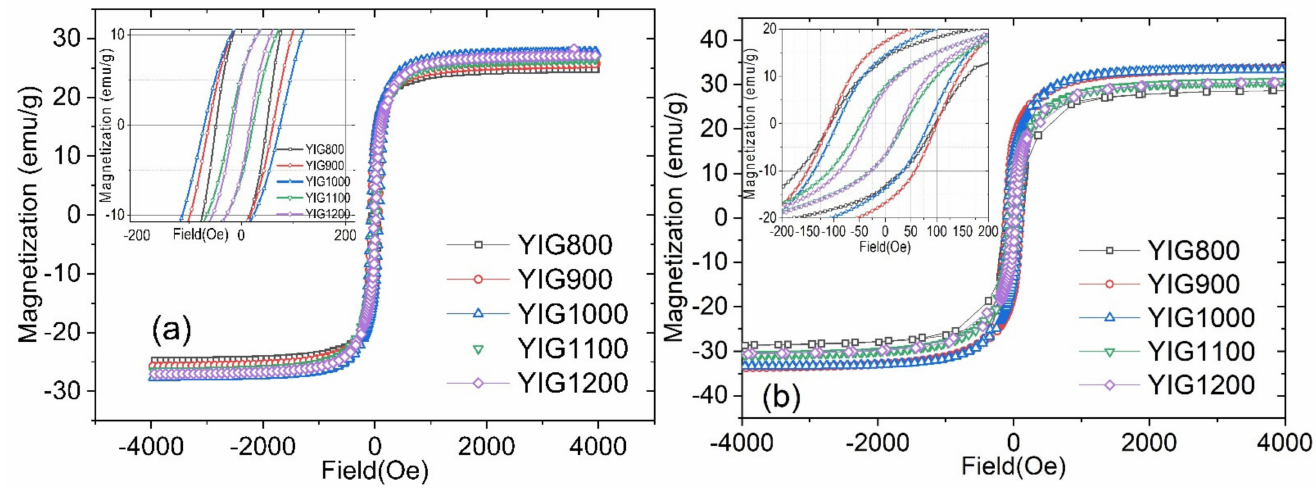
Figure 7. Hysteresis loops at 300 K ( a ) and 90 K ( b ) for synthesized